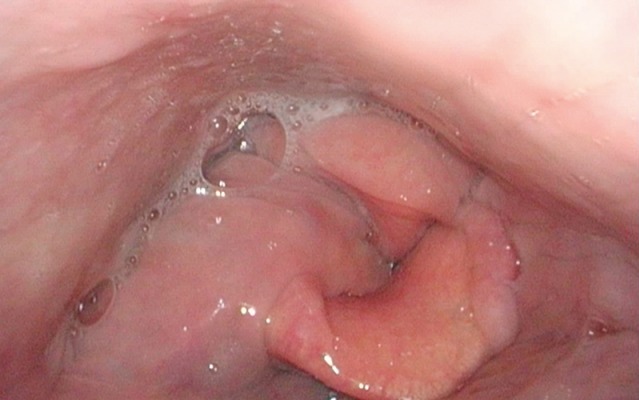
Transnasal endoscopy performed 8 days after cricohyoid epiglottopexy, postoperative swelling without detectable lumen, aspiration, and salivary retention